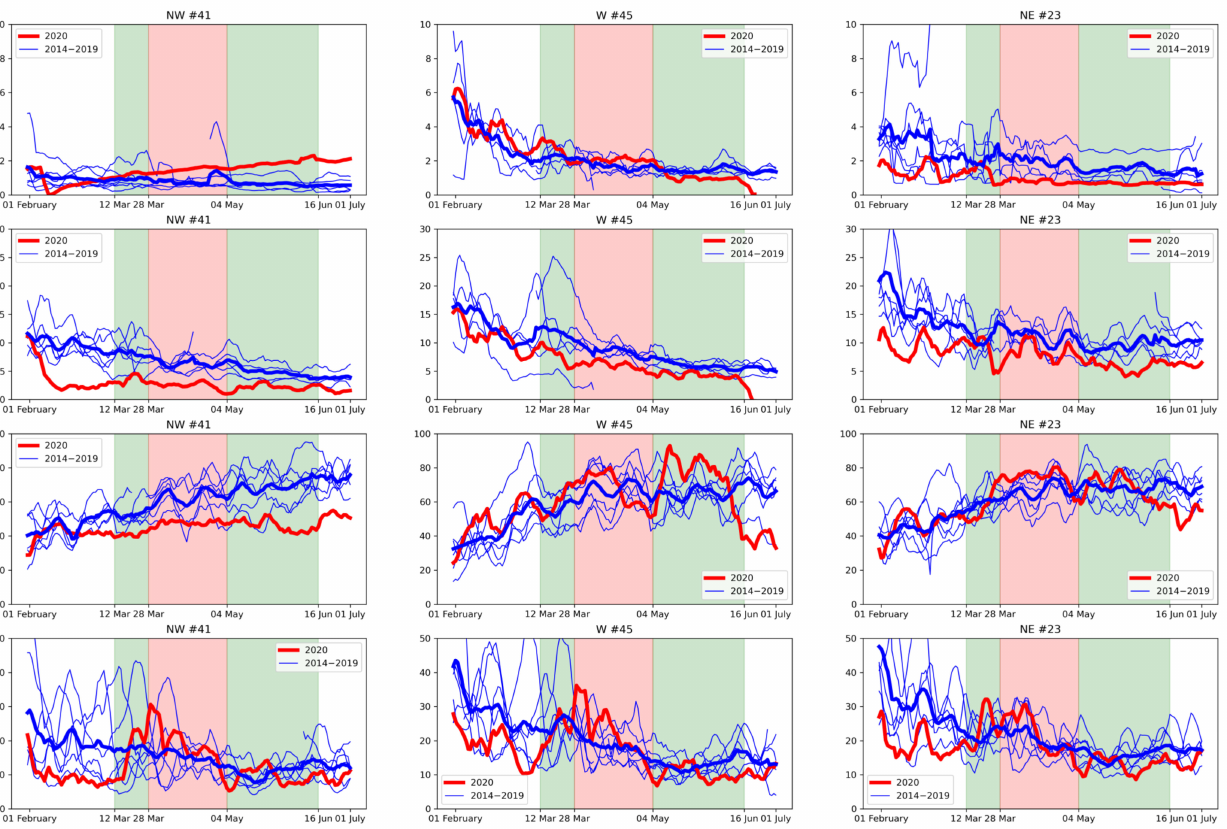
Figure 3. Seven-day rolling mean air pollutant concentrations in February–June 2020 (red) compared to the same periods of 2014–2019 (each year with thin blue lines; mean with thick blue line) at three rural monitoring sites near the borders of Hungary (sites #41, #45, and #23 in Figure 2). The public emergency period (green) and the curfew period (red) are marked with shaded